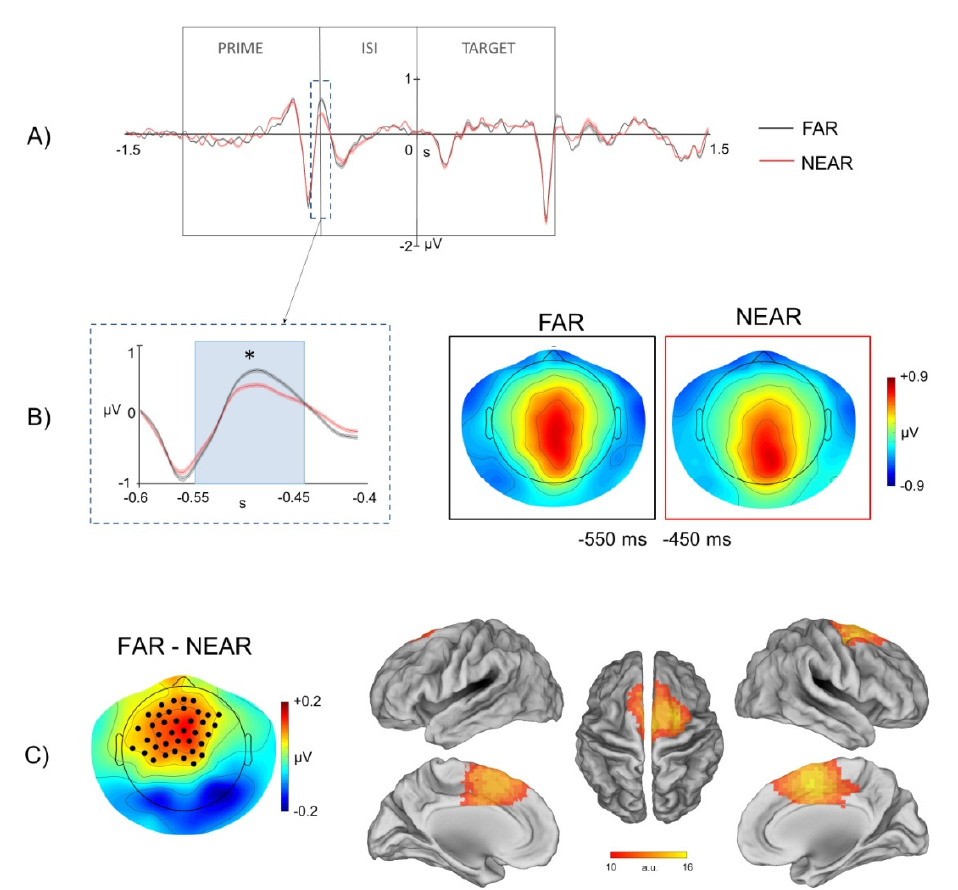
Figure 4. ERP modulation in the − 550 − 450 ms interval. ( A ). Time course of the mean ERPs for the conditions of far extrapersonal distance (black) and near extrapersonal distance (red) extracted from channels over centro-frontal areas significantly different in the paired t -test. The time window from 1500 ms before to 1500 ms after the target image onset is shown. The time intervals of prime image presentation, ISI and target image presentation are indicated. The signals inside the dashed box are zoomed in B. ( B ). Left: Time course of the mean ERPs for the far and near condition. Vertical lines display standard error of the mean across subjects of the ERP values. Gray box indicates the time interval in which the far and near conditions were significantly different (* p < 0.05). Right: Mean topography across subjects of scalp electric potentials in the significant time interval (from − 550 to − 450 ms) for the far (black box) and near (red box) conditions. ( C ). Left: Scalp topography of the far vs. near comparison. Stars indicate EEG channels with a significant far vs. near difference, as evidenced by the paired t -test. Red–yellow colors indicate a positive difference, i.e., higher ERP components values in the far vs. near condition. Right: Far vs. near difference of source localization obtained using eLORETA of grand-average ERPs in the significant time interval. Yellow–red colors indicate a positive difference, i.e., higher cortical activity in the far vs. near